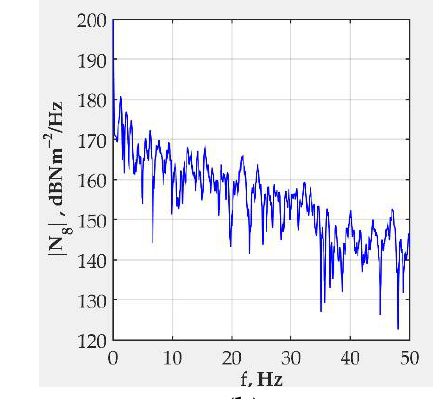
( c ) Figure 12. Magnitudes of optimal frequency response functions for the transfer channels: ( a ) 1